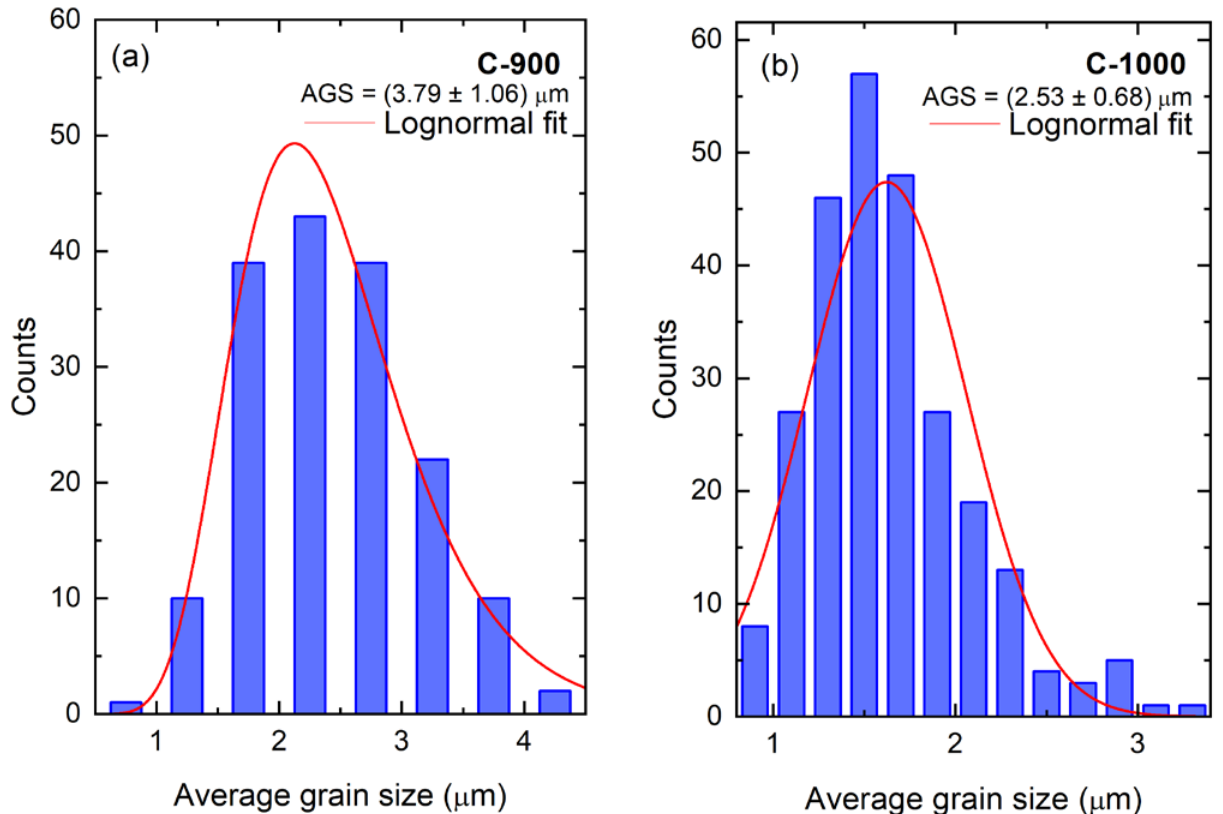
Figure 3. The average grain size of ceramics: ( a ) C-900 and ( b ) C-1000.